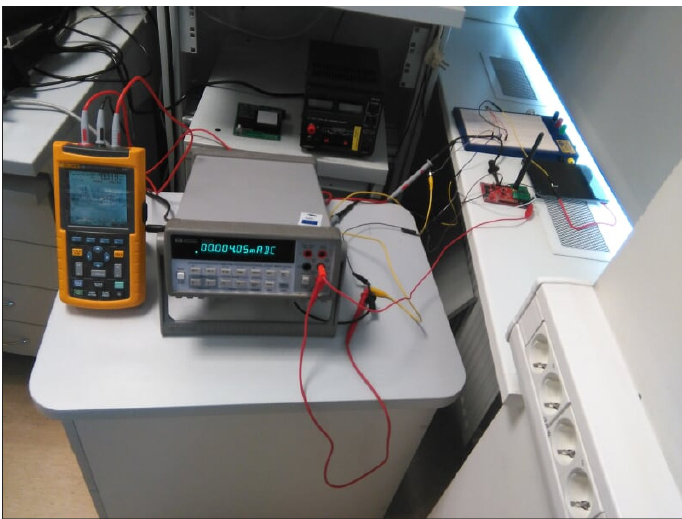
Figure 6. Photograph of the experimental setup. Here, the external solar panel is used to power the FRAM-based microcontroller. The regulated DC power supply and multi-source EH kit can be seen in the background.